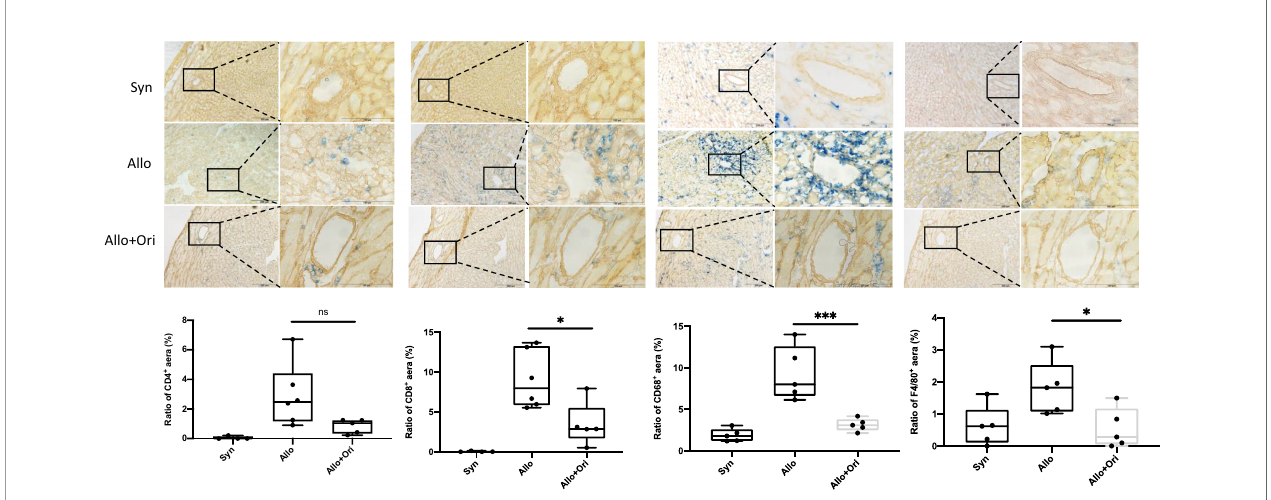
FIGURE 2 | The effect of Ori on the in fi ltration of T cells and macrophage in cardiac allografts. Cardiac grafts in syngeneic (Syn), allogenic (Allo), and Ori (Allo + Ori) recipients on POD7 were harvested and stained with anti-CD4, CD8, CD68, and F4/80 (blue) separately and collagen IV (yellowish-brown) by immunohistochemistry staining. Magni fi cation, ×100 and ×400; scale bars represent 100 and 200 µm. The positive aera ratio was analyzed and calculated from fi ve arbitrarily selected fi elds of view. Values are shown as the mean ± SD; * p < 0.05, *** p < 0.001; NS, not signi fi